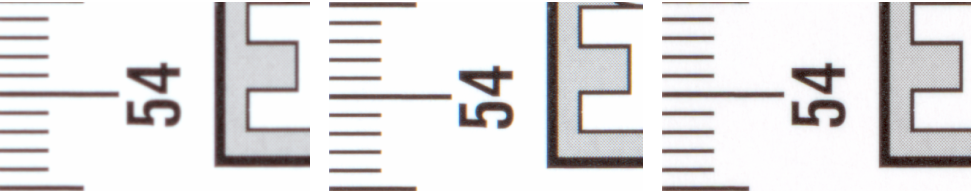
Figure 11. Unfocused with h = 0.0 cm ( left ), unfocused with h = 1.4 cm ( center ), focused with h = 0.0 cm ( right